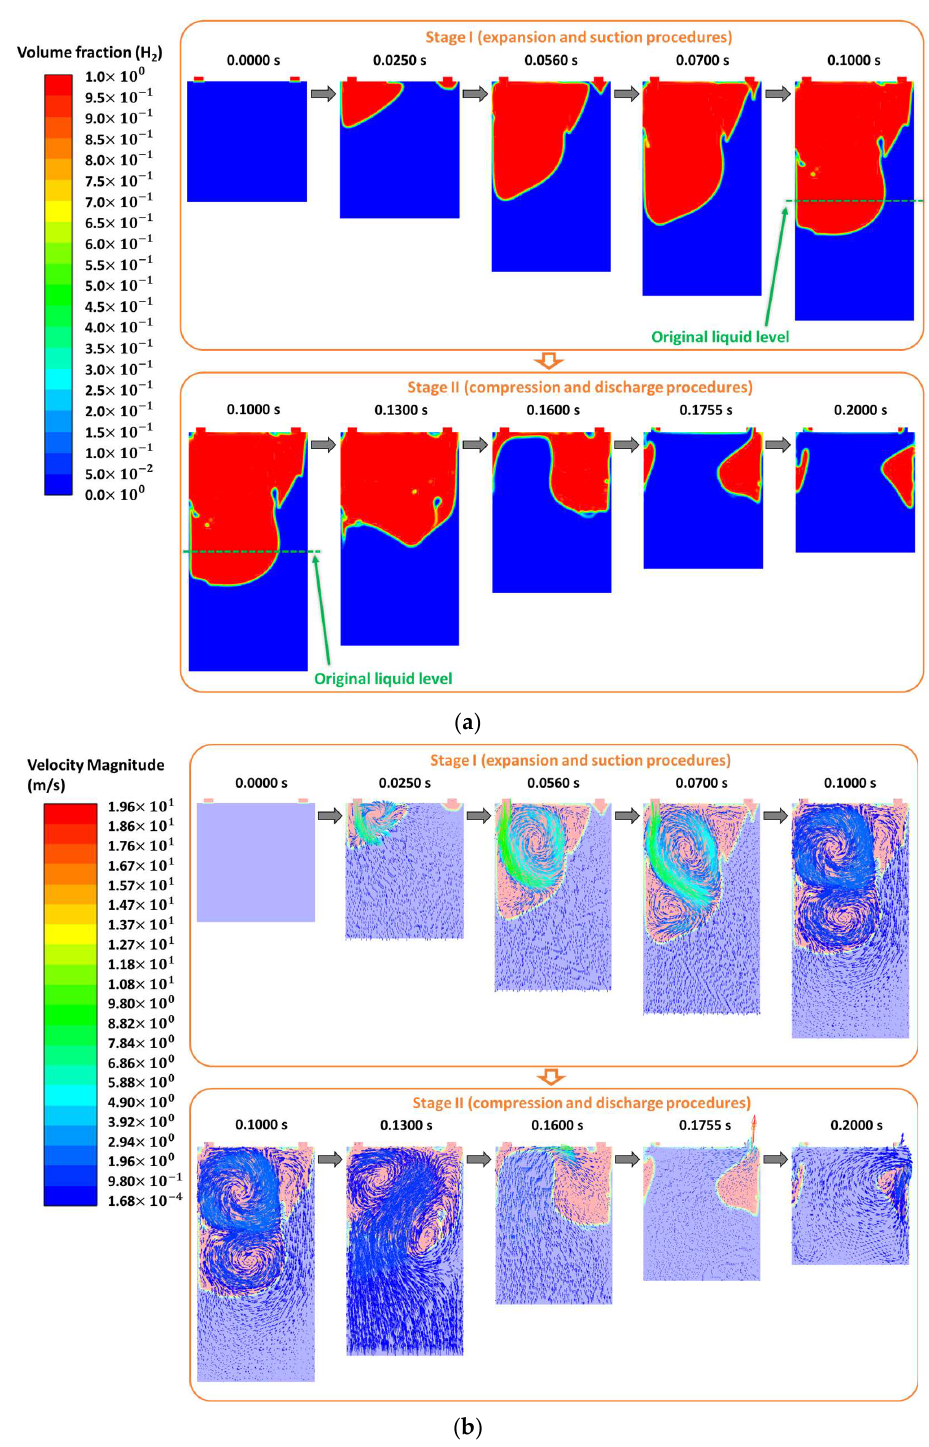
Figure 4. Results of the ( a ) volume fraction distribution and ( b ) velocity distribution (density of the ionic liquid: 1000 kg/m 3 ).